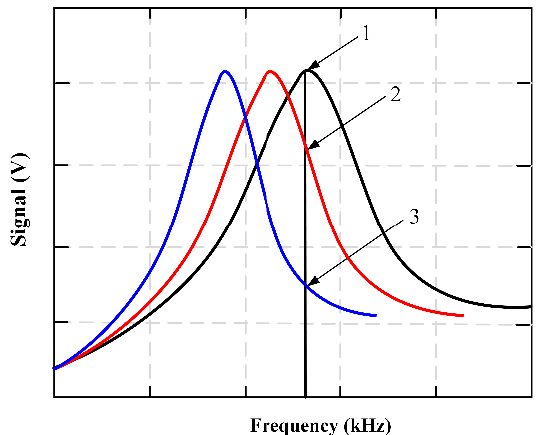
Figure 16. A graphical representation of the output signal obtained during the process of coagulation monitoring.